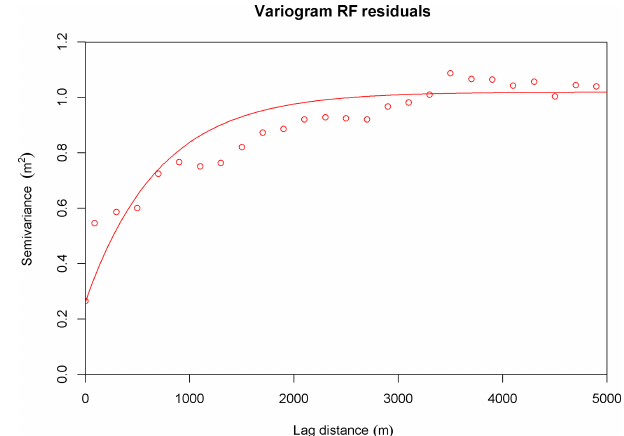
Figure 7. The computed semivariances for the RF residuals (cir- cles), based on the oob prediction. The line expresses the fitted var- iogram